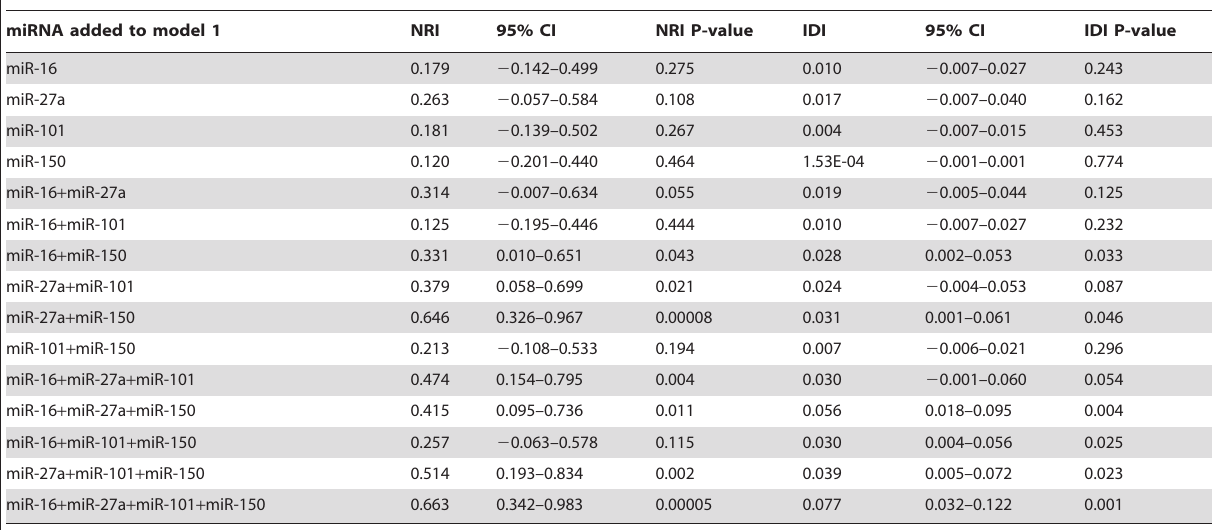
Table 4. Reclassification analyses (logistic regression).